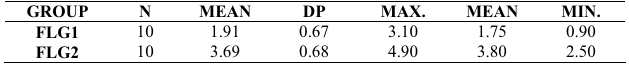
p>0.05 (Mann-Whitney